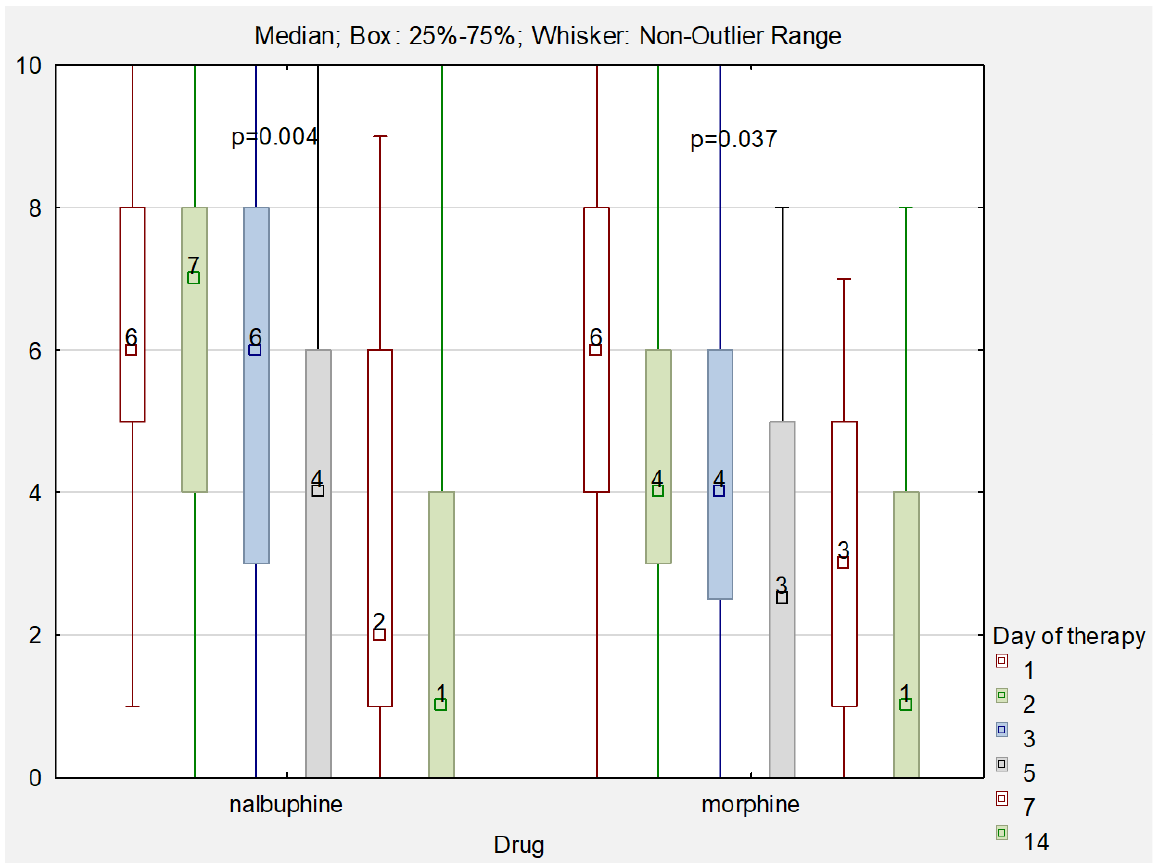
Figure 1. Comparison of pain levels on consecutive days of therapy.